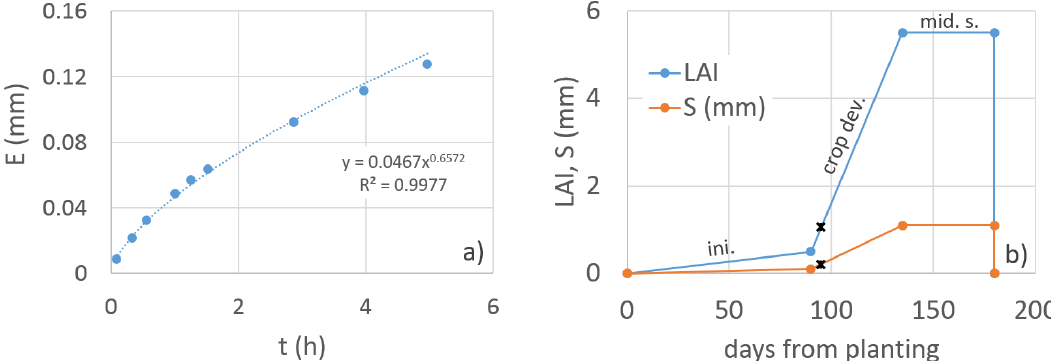
Figure 10. For Field bean, ( a ) relationship between experimental evaporation losses per unit LAI , E / LAI , during the time t (h), starting from the interception capacity, S (mm), and ( b ) assumed temporal variation of LAI and S (mm), from the day of planting (mid-November), considered for the application (Figure 11).